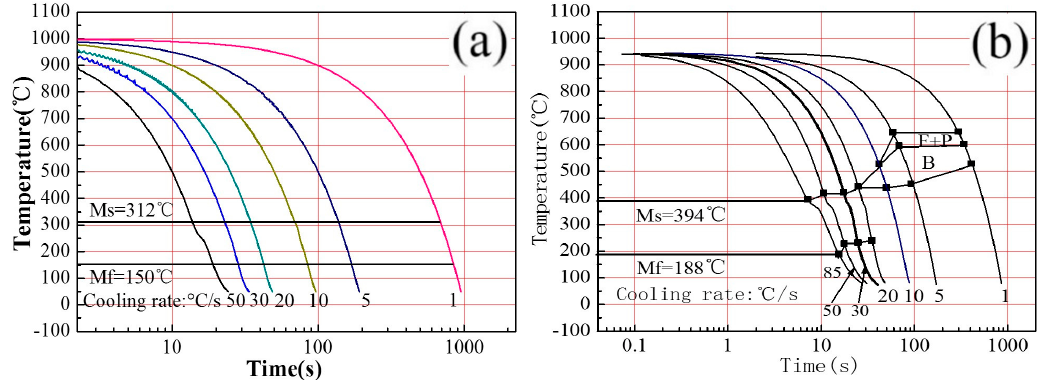
Figure 5. CCT curves of two investigated steels. ( a ) 22Mn3SiNb, ( b ) 22MnB5.